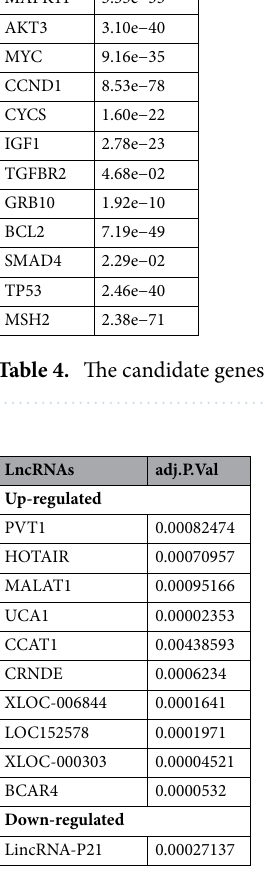
Table 5. The predicted candidate lncRNAs in rectal cancer